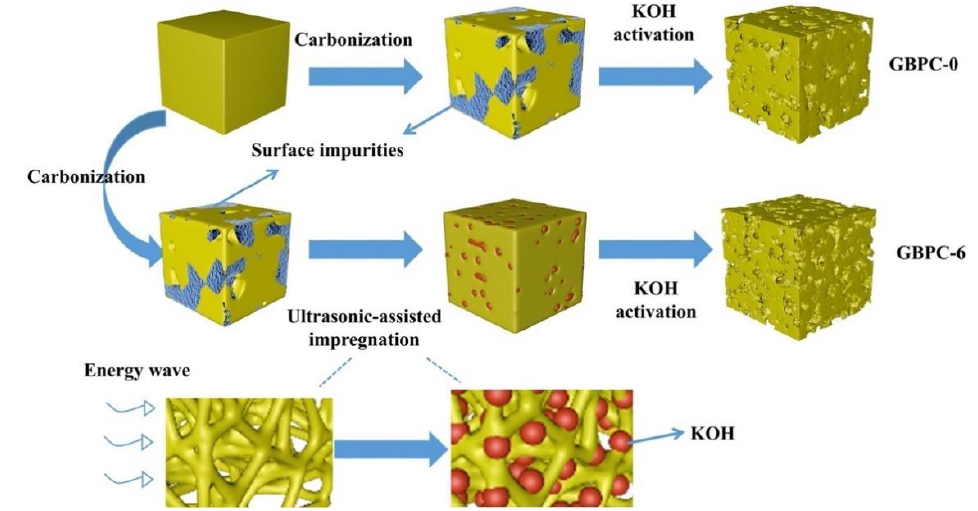
Figure 15. Microscopic process of garlic peel-based 3D hierarchical porous carbon (GBPC) synthe- sis [52]. synthesis